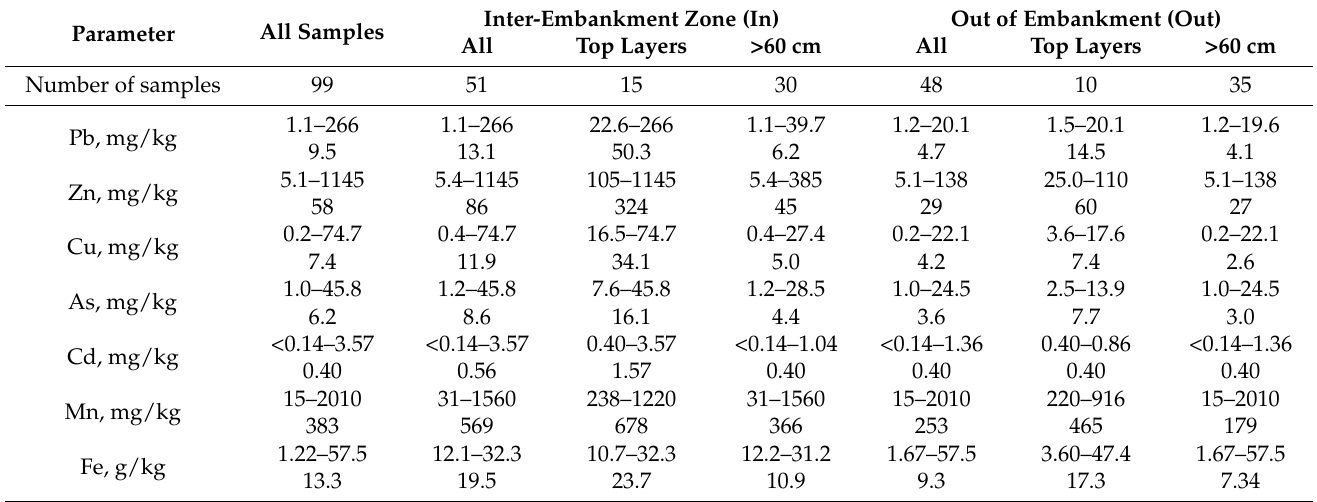
Table 2. Cumulative data on the concentrations of metal(loid)s in all sampled soil samples (N = 99) and in the subgroups: inter-embankment zone (In) and out of embankment (Out), as well as (within them): the top horizons A enriched in organic matter (Top) and deeper layers (>60 cm). Presented are: Min–Max/Median values.